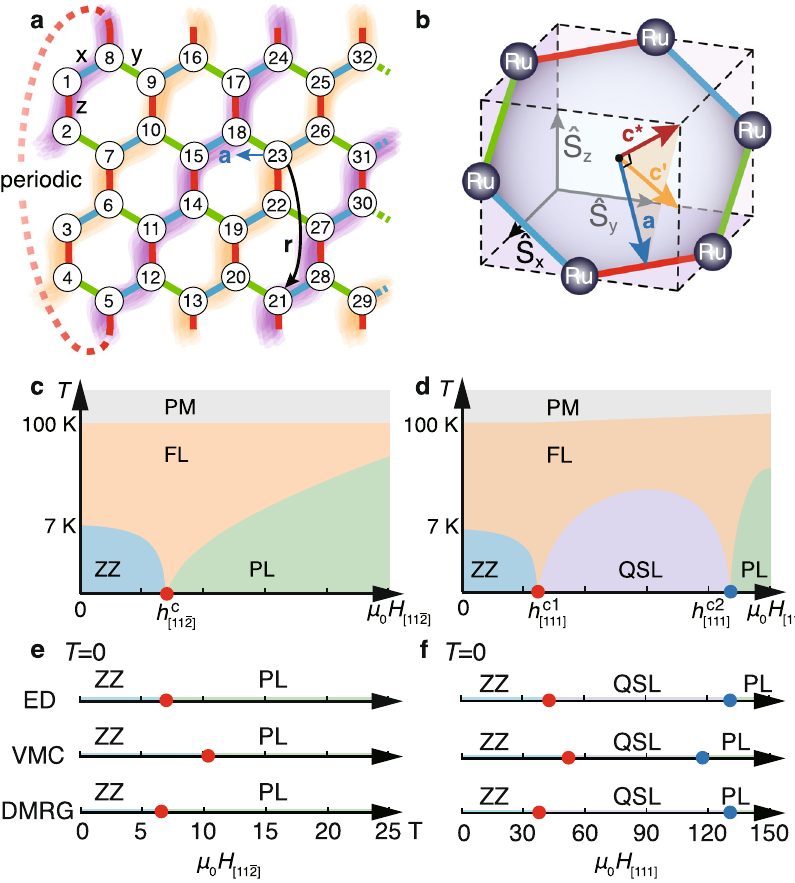
Fig. 1 Honeycomb lattice, crystalline directions, and phase diagrams. a Shows the YC W × L × 2 honeycomb lattice of width W = 4 and length L , with two sites per unit cell. The quasi-1D mapping path and site ordering is shown by the numbers, with the edge of each small hexagon set as length unit. In the zigzag magnetic order, spins align parallel along the highlighted lines, while anti-parallel between the yellow and purple lines. b shows an unit cell in α -RuCl H ∥ c * ) fi elds are presented * , and c 0 axes indicated. Finite-temperature phase diagrams under in-plane ( H 3 , with the a , c [111] ½ 11 (cid:1) 2 (cid:3) k a ) and out-of-plane ( in ( c ) and ( d ), respectively, with in-plane critical fi eld h c ’ 7 T (computed at 1.9 K), and two out-of-plane critical fi elds h c 1 (cid:6) 35 T (lower) and ½ 111 (cid:3) ½ 11 (cid:1) 2 (cid:3) h c 2 (cid:6) 120-130 T (upper), estimated at 0 K. In the phase diagrams, ZZ stands for the zigzag phase, PM for paramagnetic, FL for fractional liquid, and PL for ½ 111 (cid:3) the polarized phase, with the QPTs (red and blue points) indicated. e , f show the T = 0 phase diagrams obtained by ED, VMC and DMRG, where the in- plane critical fi eld is pinpointed at between 6.5 and 10 T, while two QPTs and a QSL phase are uncovered under out-of-plane fi